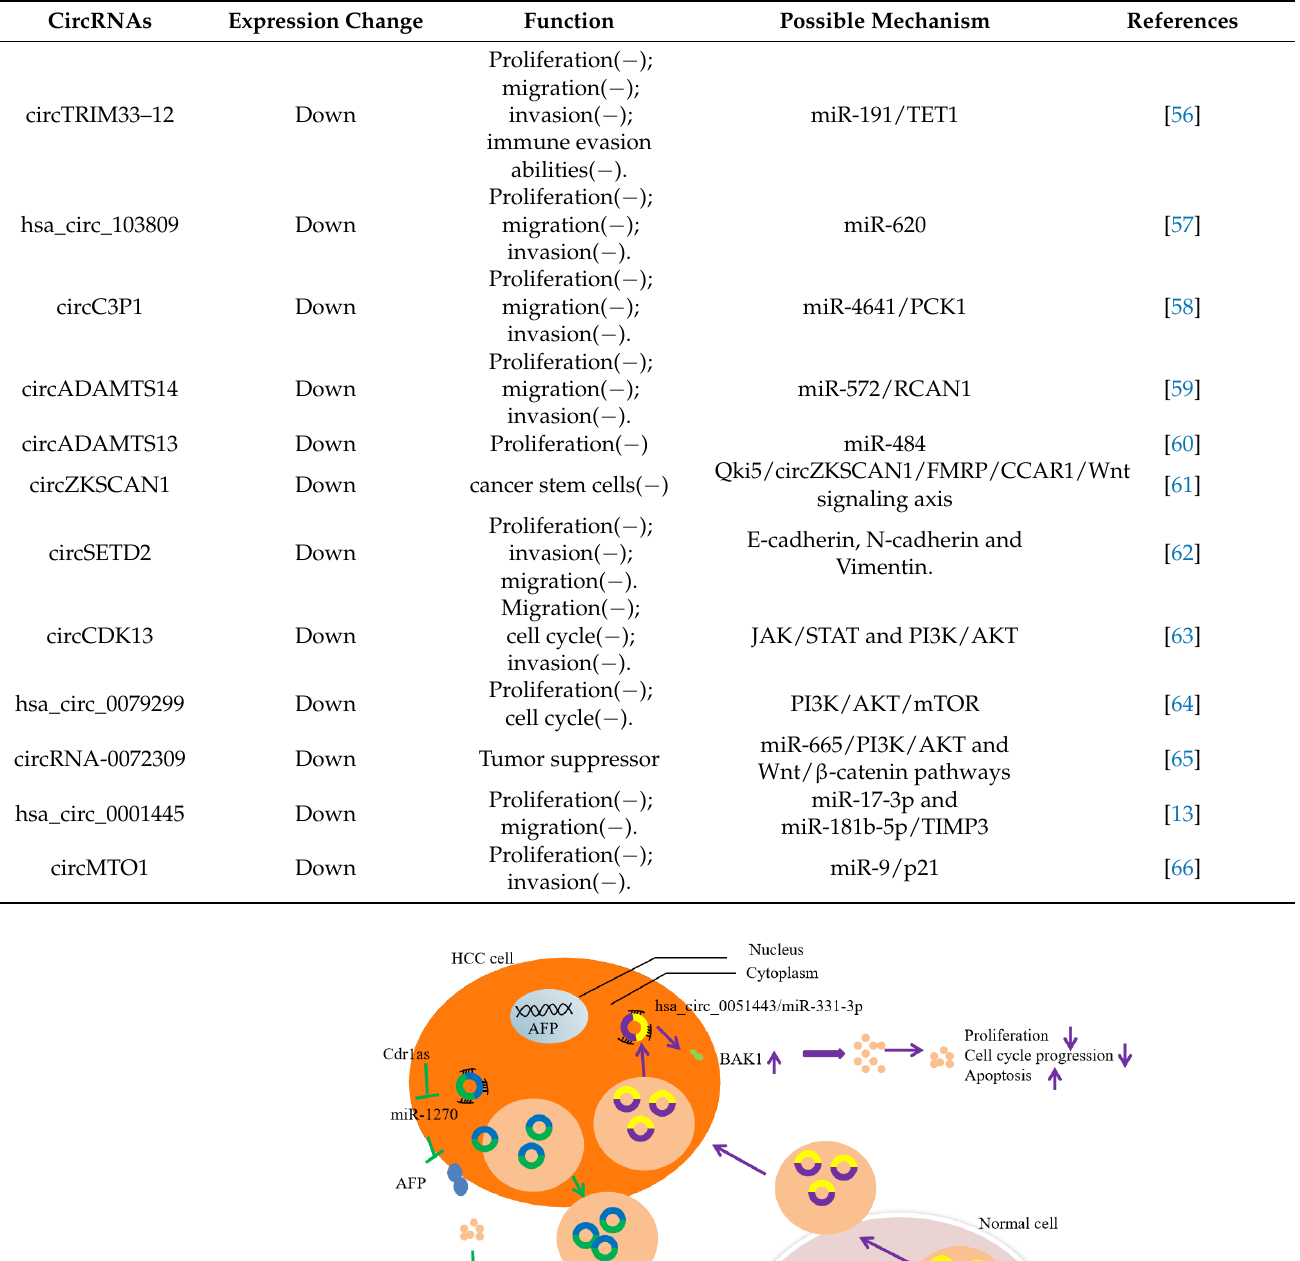
Table 3. Expression and Function of tumor suppressor circRNA in HCC.